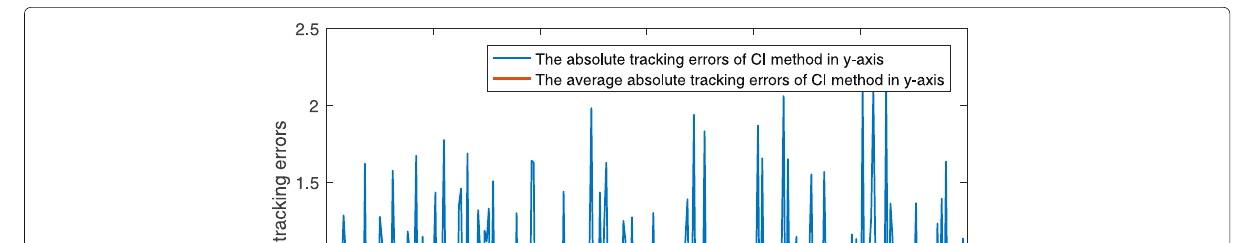
Fig. 19 The absolute tracking errors of RFE in x -axis with varied cross-correlation